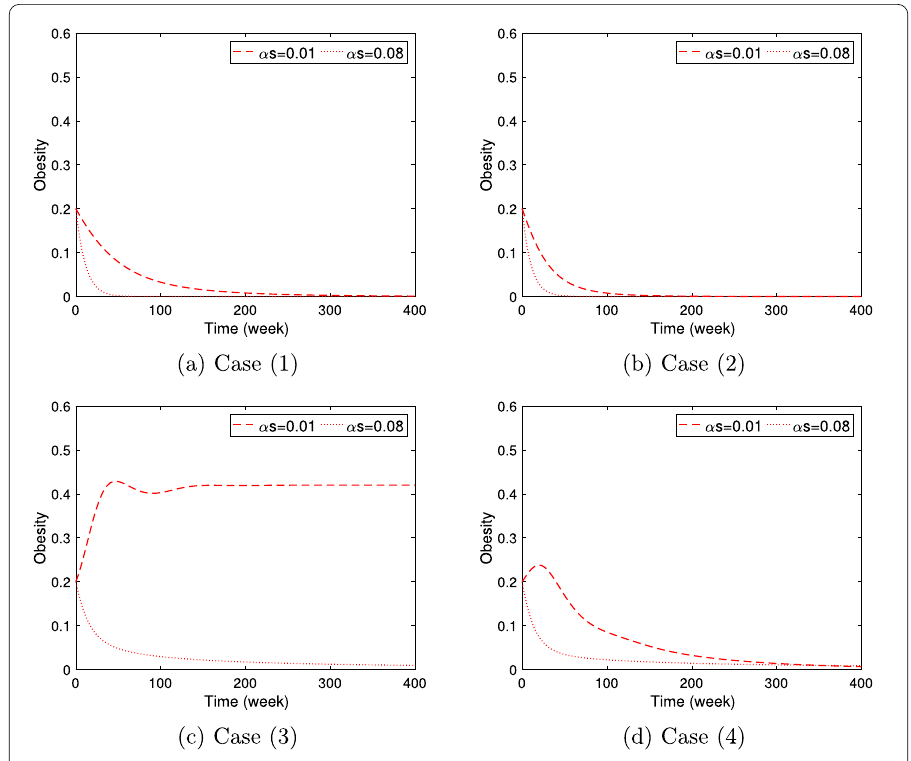
Figure 7 Time variation of obesity for low and high workout raters with ( a ) low peer pressure rates, ( b ) low fast food pressure rates and high quitters peer pressure rates, ( c ) hight fast food peer pressure rates and low quitters peer pressure rates, and ( d ) high peer pressure